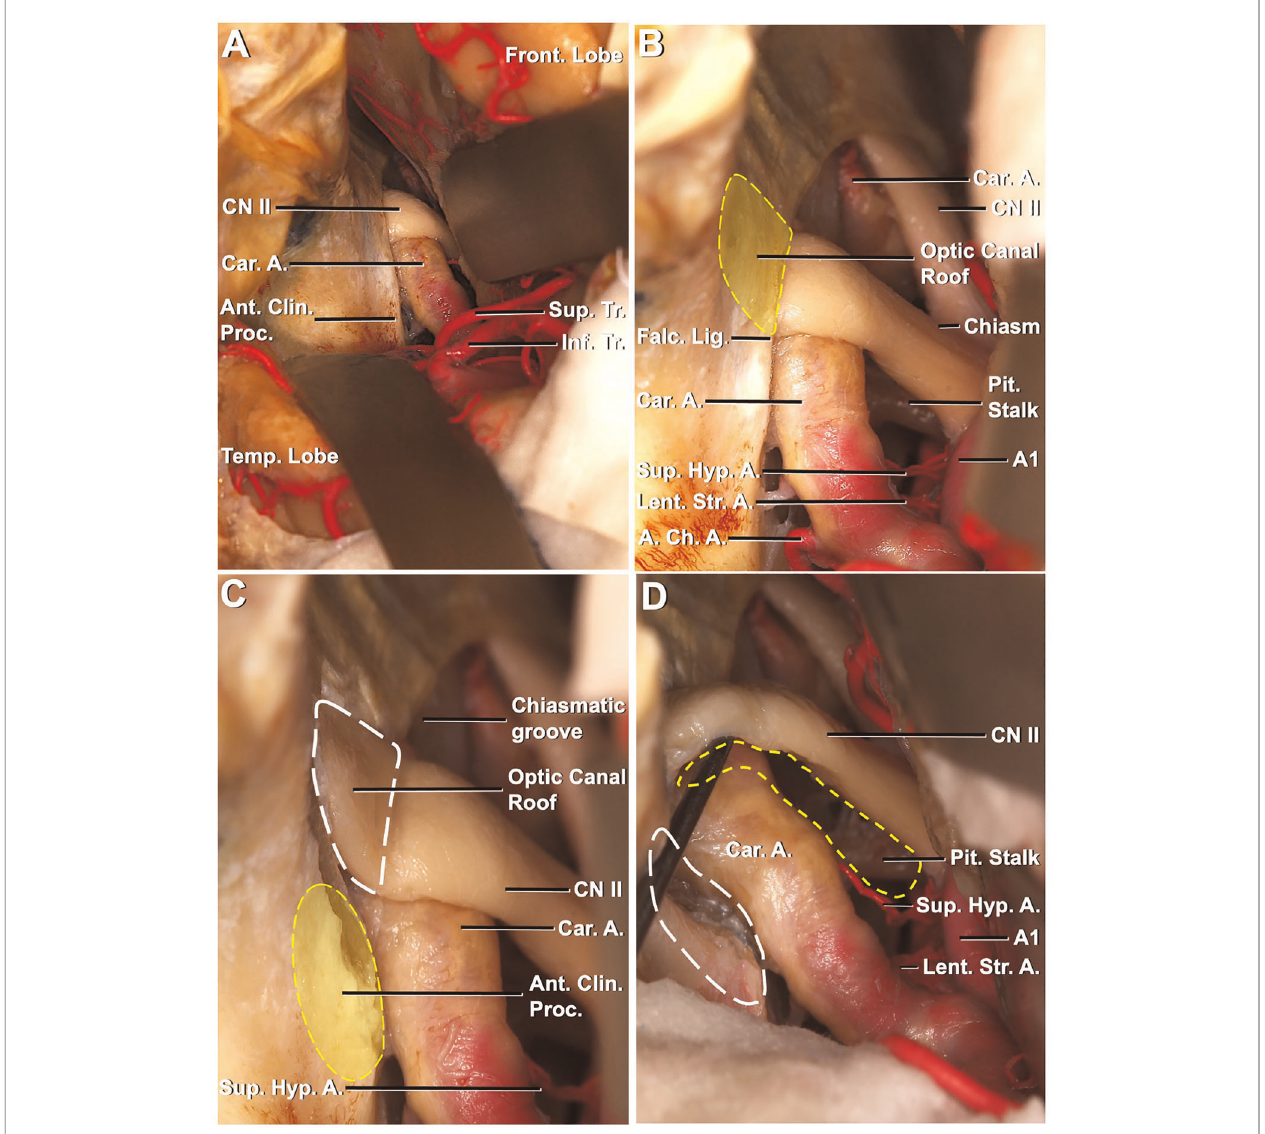
FIGURE 4 | Left pterional exposure of the preoptic chiasm and circle of Willis, the ipsilateral approach to the left superior hypophyseal artery. ( A ) Left frontotemporal bone fl ap is elevated, and the dura is opened. The left frontal and temporal lobes have been retracted to expose the left carotid artery entering the dura medial to the anterior clinoid process. The left optic nerve, anterior clinoid process, and prechiasmatic area are seen. ( B ) Exposure has been extended between the chiasm and the frontal lobe. Pituitary stalk and left superior hypophyseal artery are seen between the left optic nerve and left carotid artery. The optic canal roof is depicted by a dashed yellow line. ( C ) Optic canal roof, depicted by a dashed white line, is removed. The anterior clinoid process is depicted by a dashed yellow line. ( D ) Anterior clinoid process, depicted by a dashed white line, is removed and the left optic nerve is mobilized. The corridor for the ipsilateral approach to the left superior hypophyseal artery is seen (dashed yellow line) between the left optic nerve and the mobilized left carotid